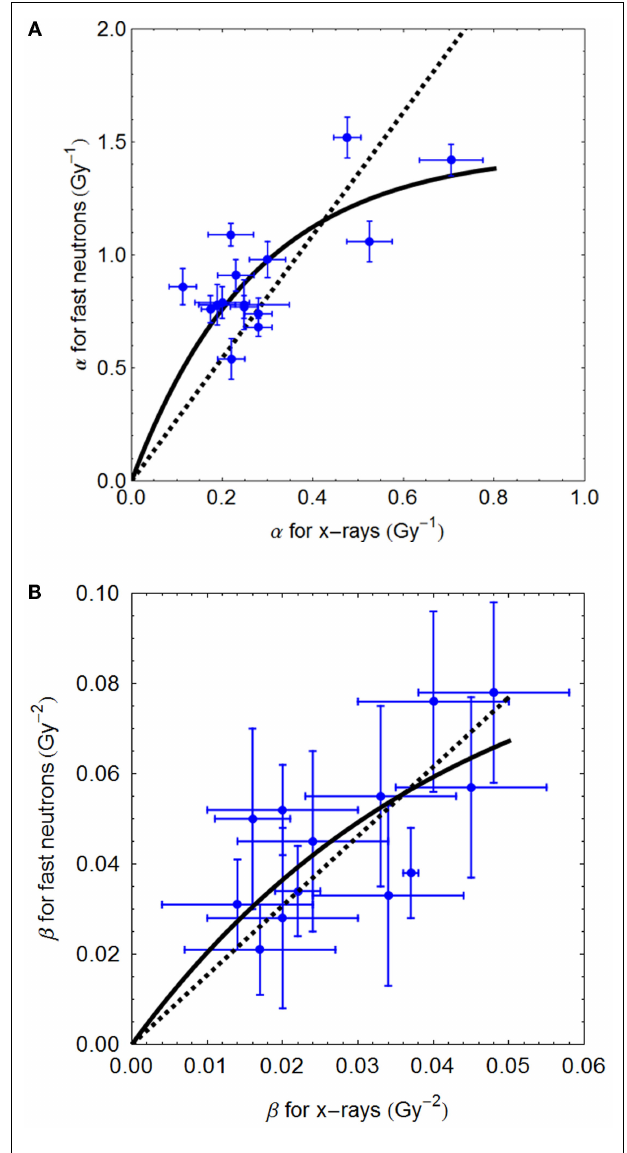
FIGURE 2 | (A,B) Sixty-four megavolt fast neutron relationships between low and high LET radiosensitivity parameters. Linear no-intercept and non-linear least squares fits are respectively: (A) α H = 2.72 α L and α H = 5.37/3.68 (1 (cid:0) e (cid:0) 3.68 α L ); (B) β H = 1.57 (cid:1) β L and 2.29/23.57(1 (cid:0) e (cid:0) 23.57 β L ) using Mathematica